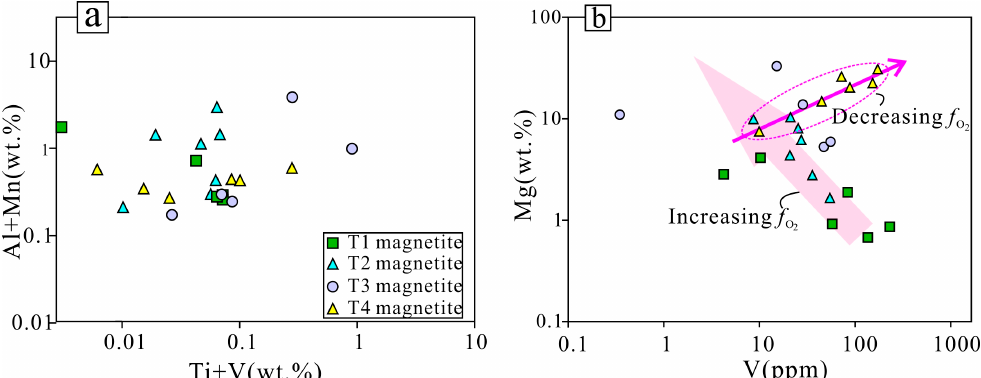
Figure 10. ( a ) Al + Mn vs. Ti + V correlation diagram; ( b ) Mg vs. V plot.